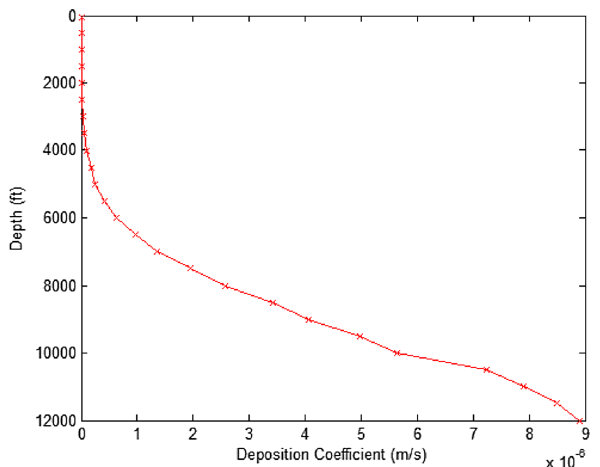
Fig. 12 Asphaltene deposition coefficient profile